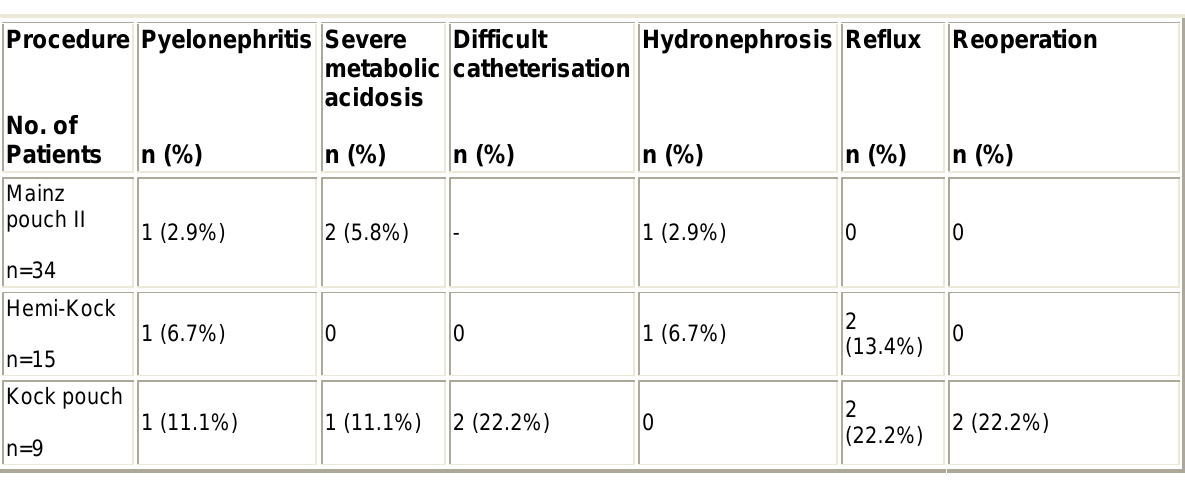
Late complication rates of three types of continent urinary